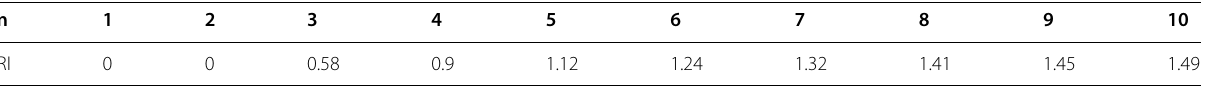
for multi-hazard scenarios based on a simplified approach (Risk ity).